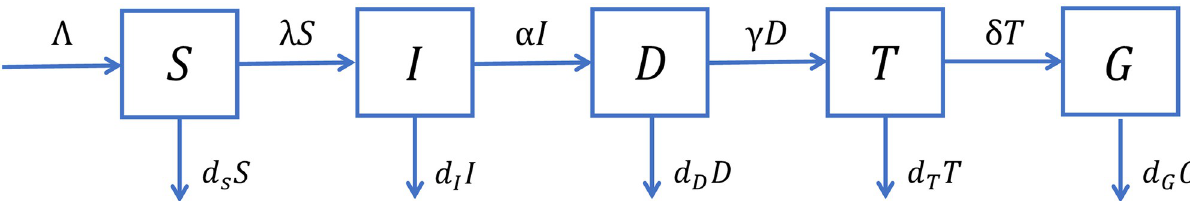
Fig 1. Schematic diagram of the model. Five classes of individuals: Susceptible individuals ( S ), HIV-infected but not yet diagnosed ( I ), diagnosed HIV cases but not yet initiated ART ( D ), initiated ART ( T ), dropped out of ART ( G ). ART: Antiretroviral treatment. https://doi.org/10.1371/journal.pone.0270525.g001 Table 2. List of